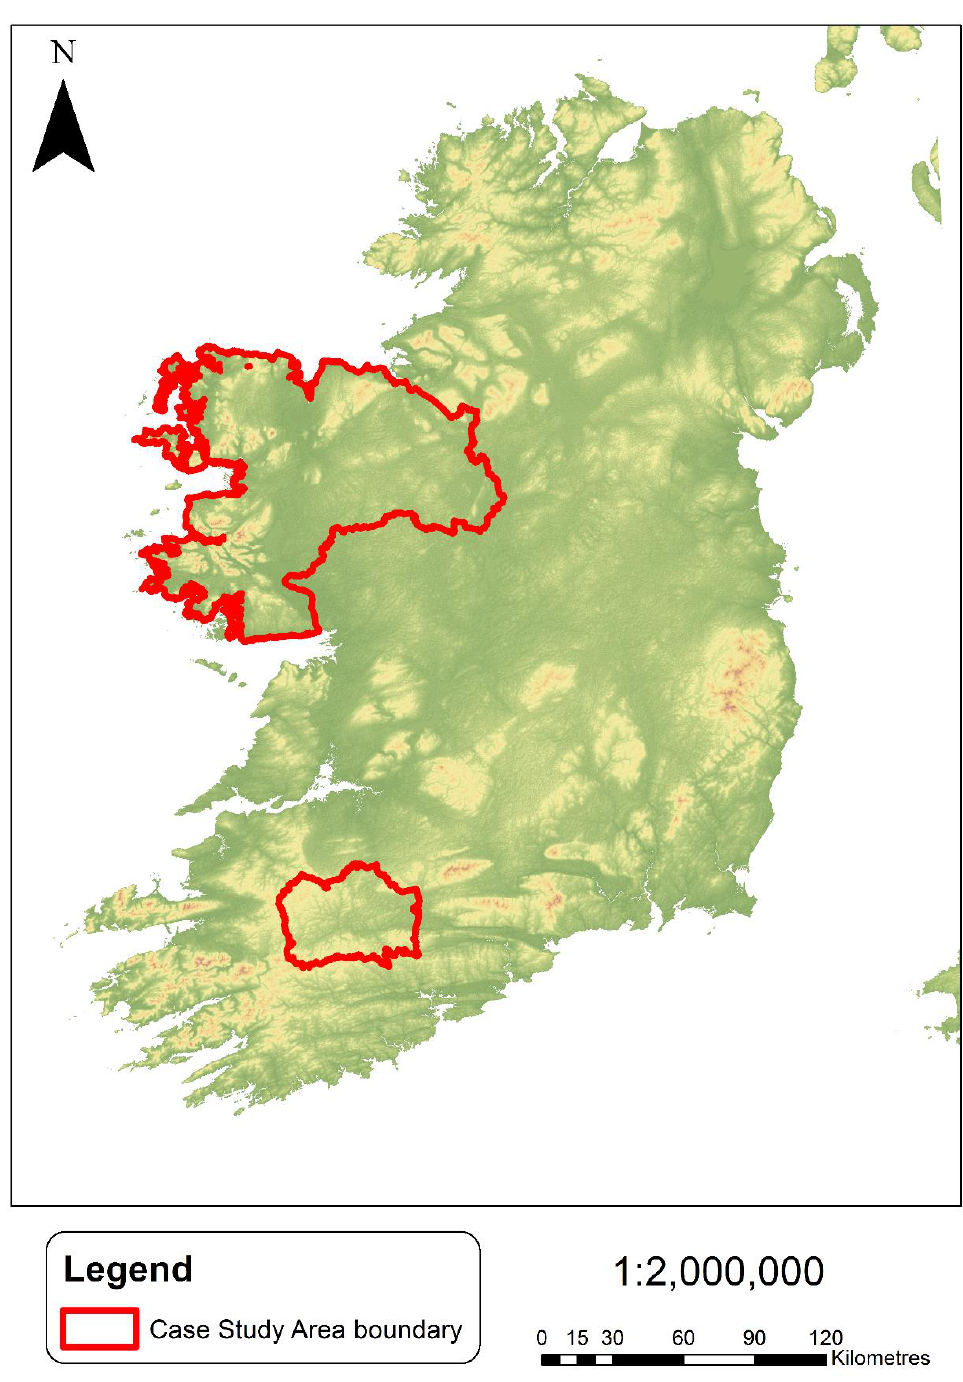
Figure 1. Location of both case study areas: Western Peatlands (WP, top); and Newmarket (NM, bottom).